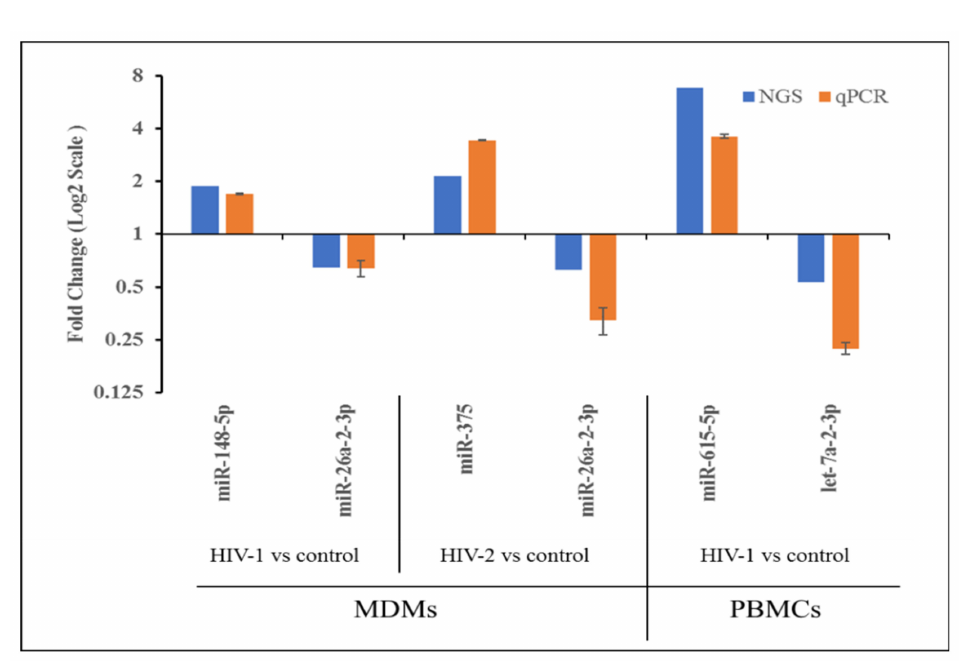
Figure 5. Expression pattern validation of miRNAs selected from the NGS data by